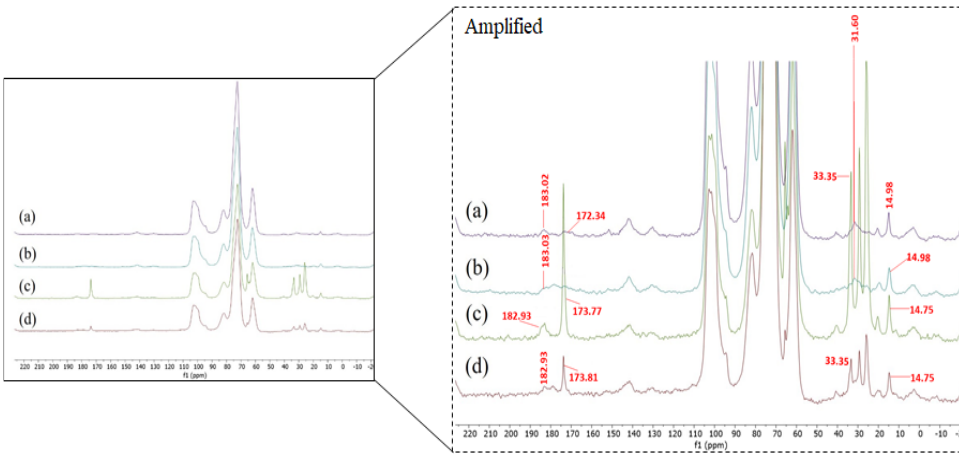
Figure 1. Solid-state 13 C CP MAS NMR spectra from the di ff erent butyrylated starch-based spa- ghe tt i-type pasta systems studied: ( a ) NSt + Bu, ( b ) NSt + Bu + TAc, ( c ) OSt + Bu and ( d ) OSt + Bu + TAc.